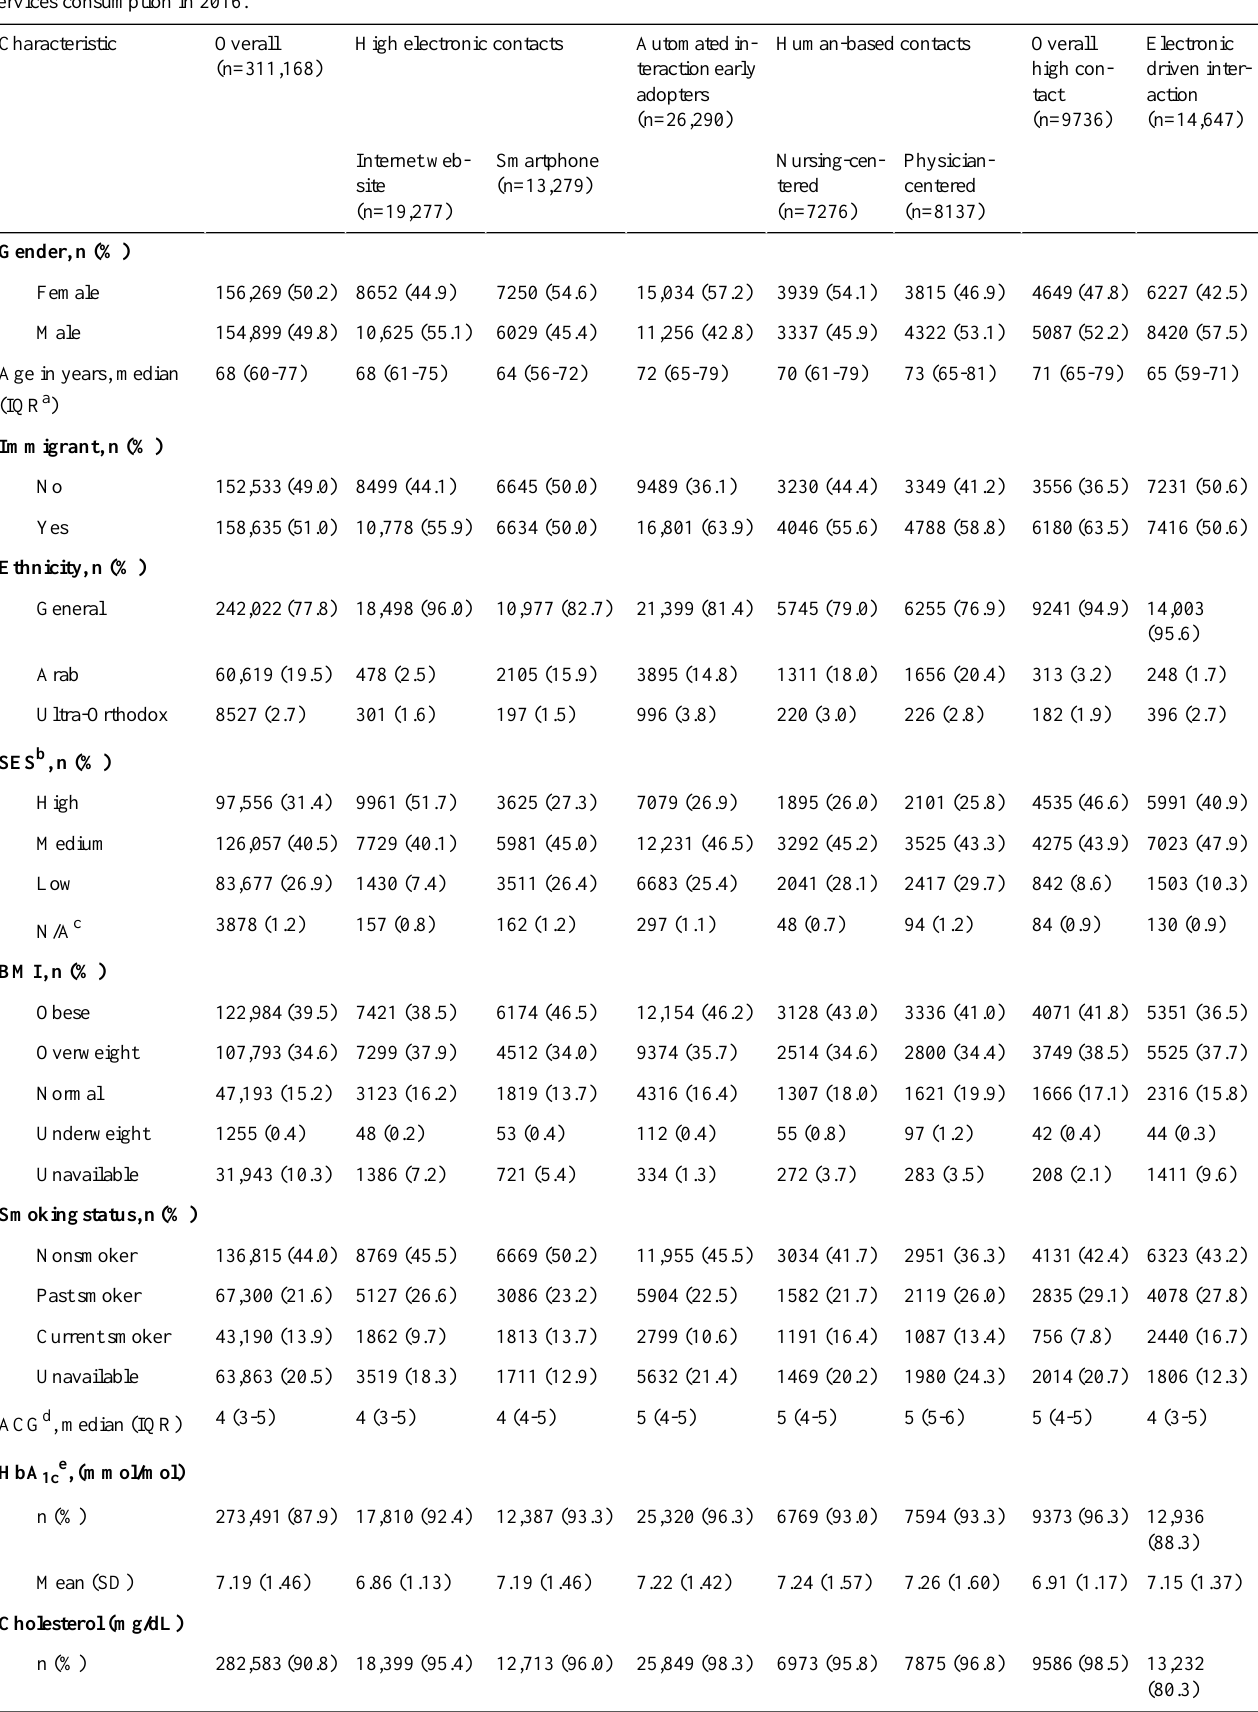
Table 3. Sociodemographic, clinical, and biological measurements data summary for patients with diabetes who had a moderate-to-high health care services consumption in